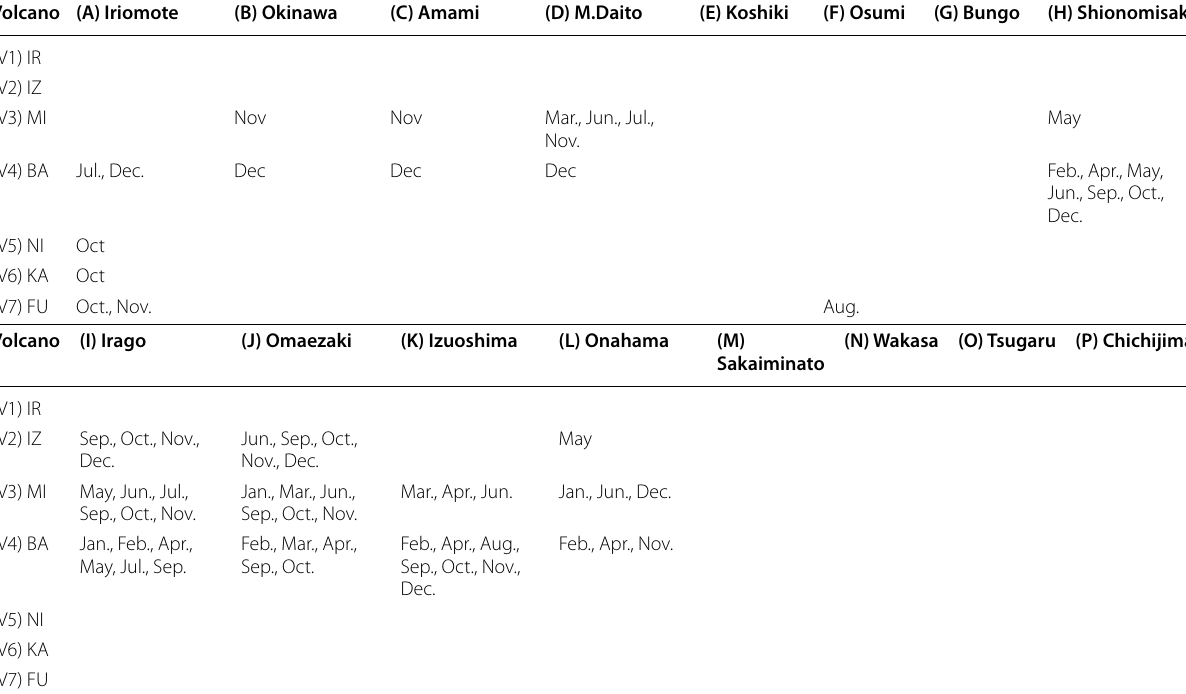
Table 4 Paths for which the yearly mean virtual pumice number was larger than 100 and the monthly standard deviation was more than twice as large as the yearly standard deviation Volcano (A)